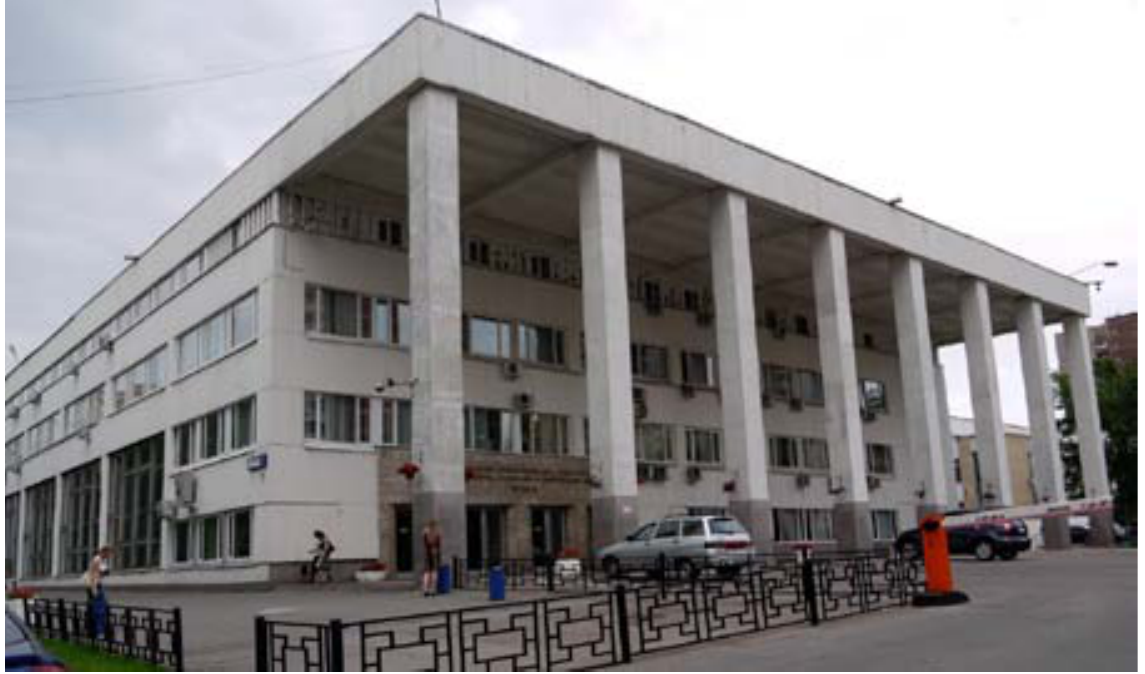
Figure 1 . Main entrance of MESI at the campus in Moscow (Source: private photograph, June,